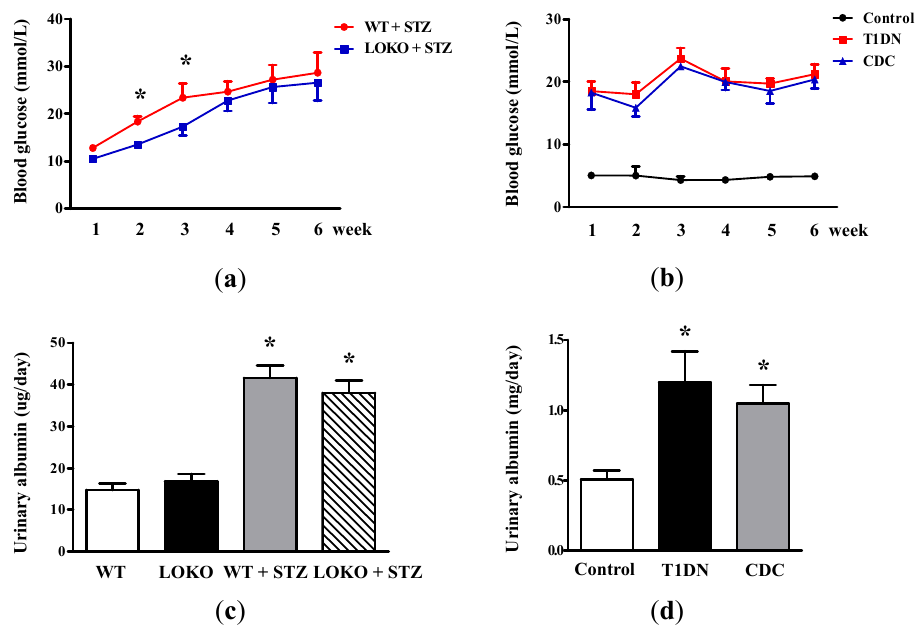
Figure 1. Effect of 12-LO on fasting blood glucose and MAU in type-1 diabetic models. ( a ) Fasting blood glucose levels in WT, 12-LO knockout (12-LOKO), WT + STZ and LOKO + STZ mice; n = 9 in each group; * p < 0.01 vs. LOKO + STZ; ( b ) fasting blood glucose levels in control, type-1 diabetic rats and CDC-treated rats; n = 10 in each group; ( c ) the level of MAU in WT, LOKO, WT + STZ and LOKO + STZ mice; n = 9 in each group; * p < 0.01 vs. WT or LOKO; ( d ) the level of MAU in control, type-1 diabetic rats and CDC-treated rats; n = 10 in each group. Data are presented as the mean ± standard deviation (SD); * p < 0.01 vs. the control.